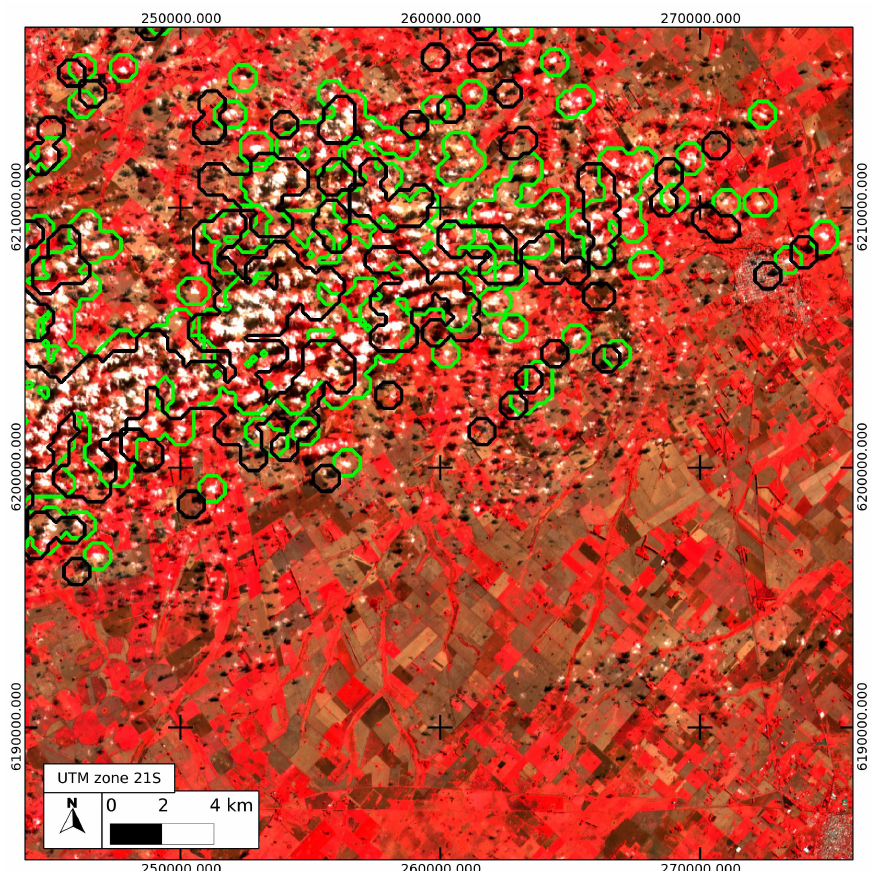
Figure 6. Example of a SPOT-4 (Take 5) image acquired in Argentina on 29 April with small undetected clouds. The detected clouds are circled in green and their shadows in black.